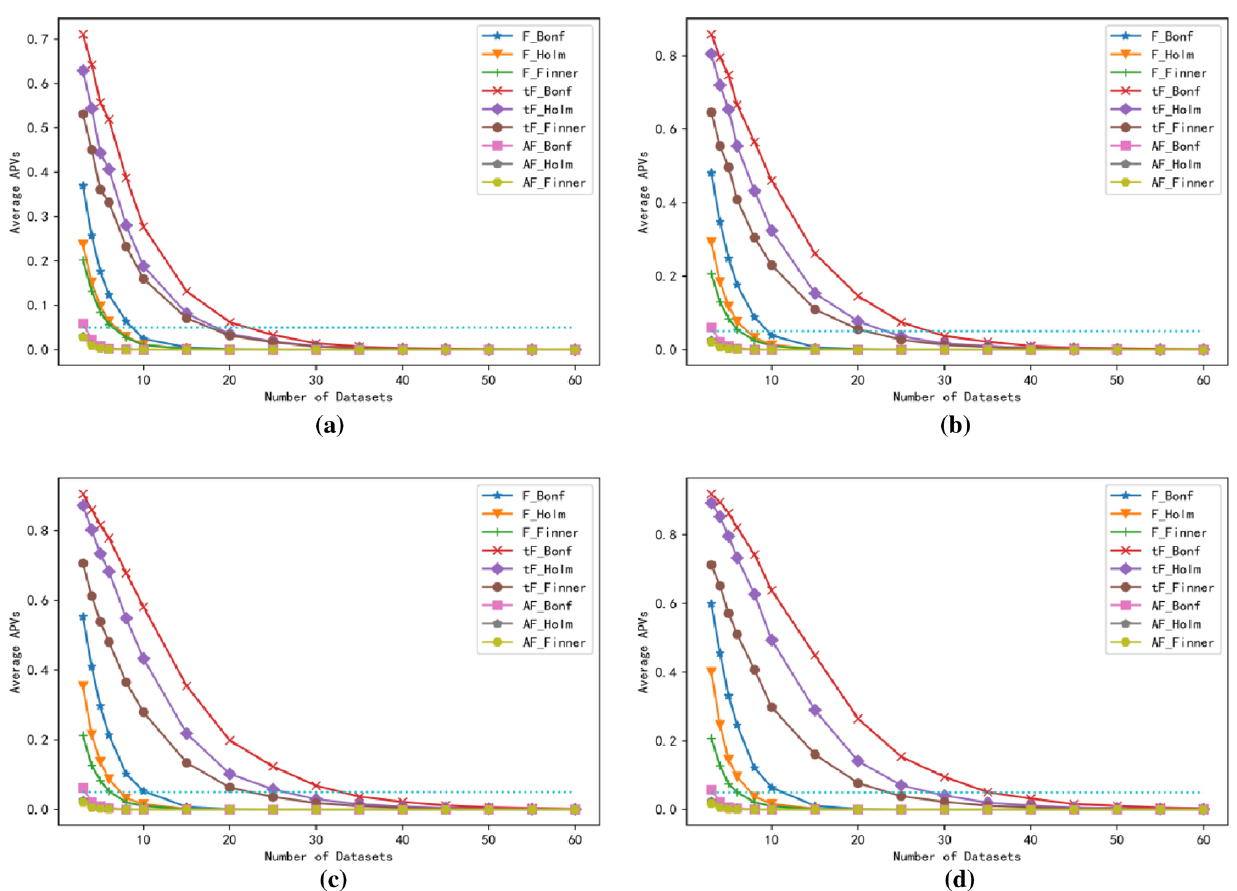
Fig. 7 Average APVs of different nonparametric statistical tests under the experiment setting ii: a the number of algorithms K = 4; b K = 6; c K = 8; d K =